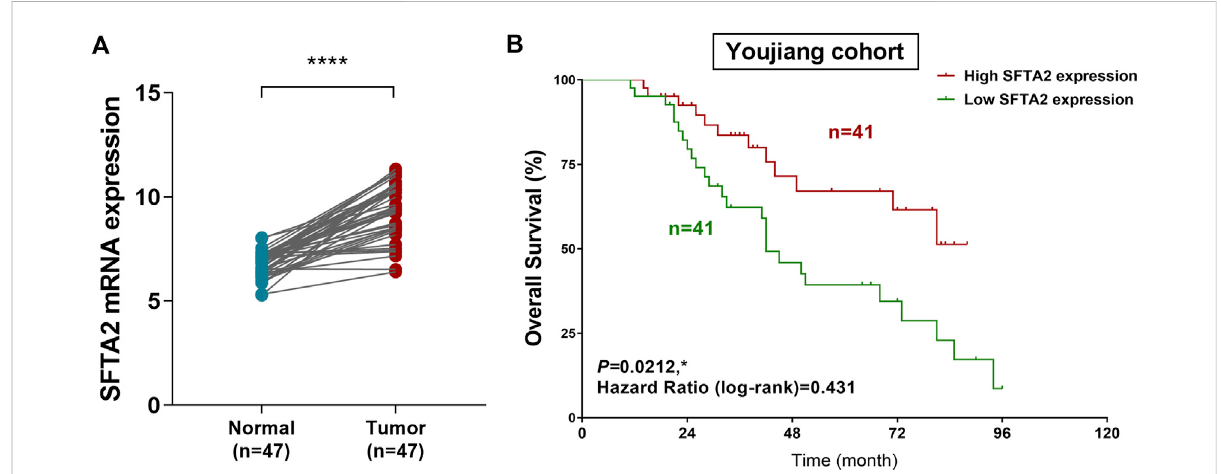
FIGURE 6 Expression and prognostic validation of SFTA2 expression in outcomes of NSCLC patients from the real-world cohort. (A) We compared the expression of SFTA2 in normal tissues ( n = 47) and NSCLC ( n = 47) tissues using Student ’ s t test. (B) Kaplan – Meier survival analysis and log-rank test reveal the prognostic value of SFTA2 expression in 82 patients from the Jiaxing